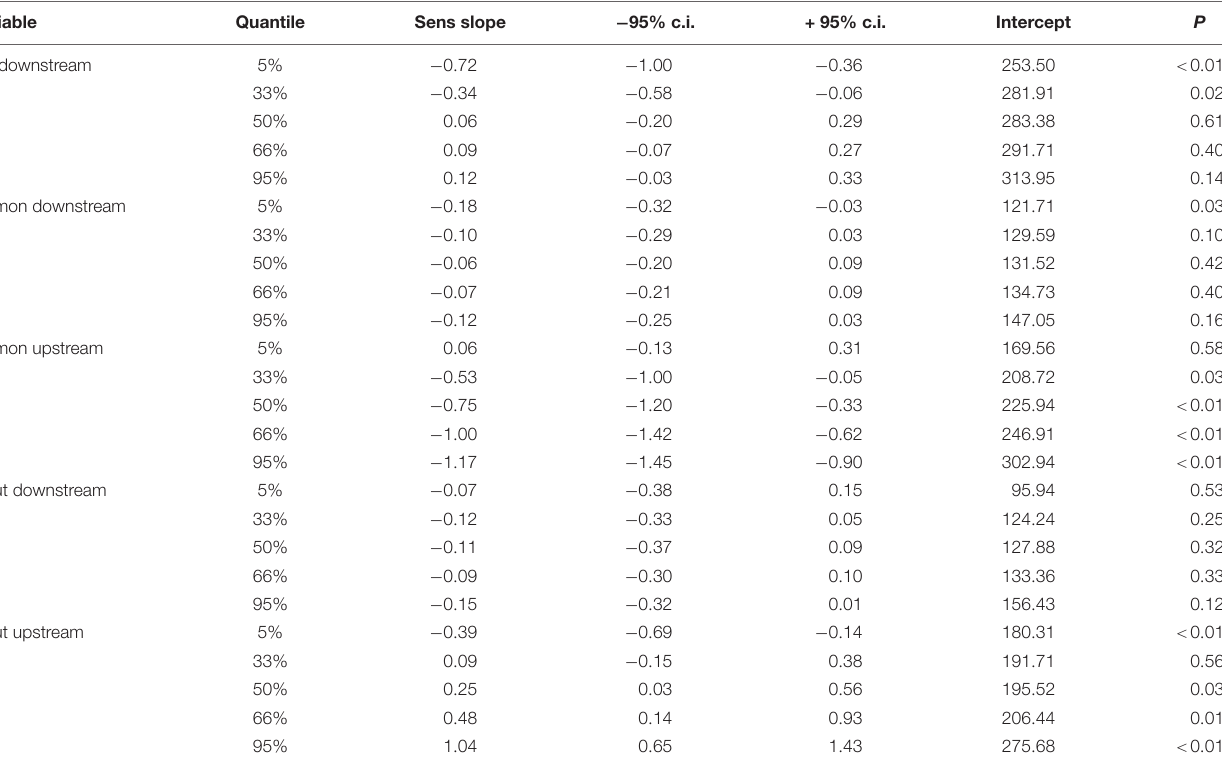
TABLE 1 | Trends (Theil sens estimate of slope) in migration phenology (days year − 1 ) of diadromous fish migrating through the Burrishoole traps 1970–2020, based on the day of the year by which quantiles of the annual run had passed through the relevant (upstream or downstream) traps. Variable Quantile Sens slope − 95% c.i.